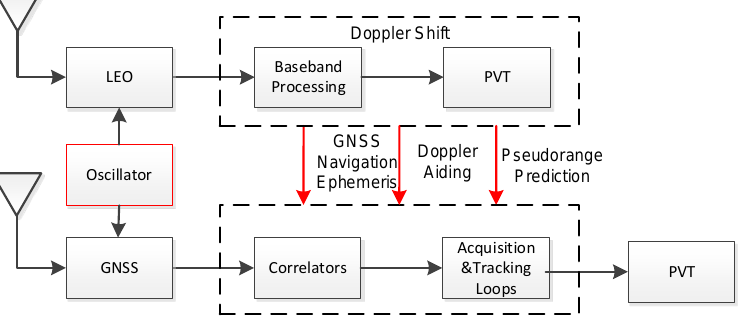
Figure 1. Low Earth Orbit (LEO)-augmented Global Navigation Satellite System (GNSS) receiver system structure.